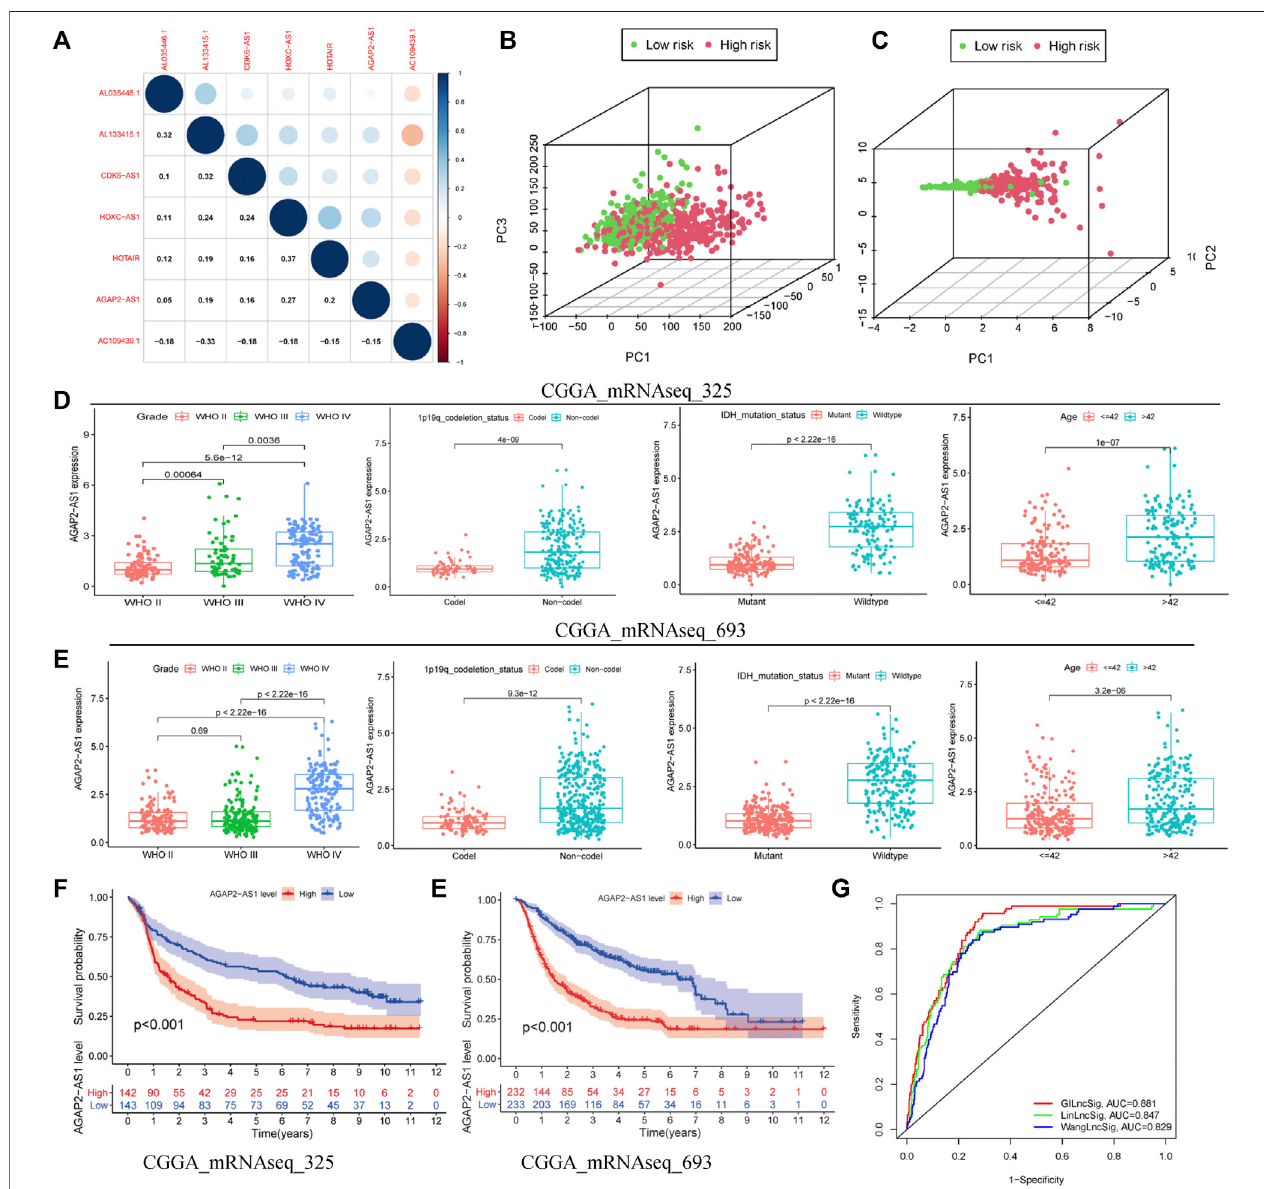
FIGURE 5 | Superiority of the GILncSig model. (A) Correlation analysis of lncRNAs derived from GILncSig. (B) Principal component analysis based on the expression of all genes. (C) Principal component analysis based on the expression of lncRNAs from GILncSig. Clinical features based on one lncRNA (AGAP2-AS1) of GILncSig signature in CGGA-mRNAseq-325 (D) and CGGA-mRNAseq-698 (E) . Survival curve based on one lncRNA (AGAP2-AS1) of GILncSig in CGGA-mRNAseq- 325 (F) and CGGA-mRNAseq-698 (G) . (H) One-year ROC curve based on multiple